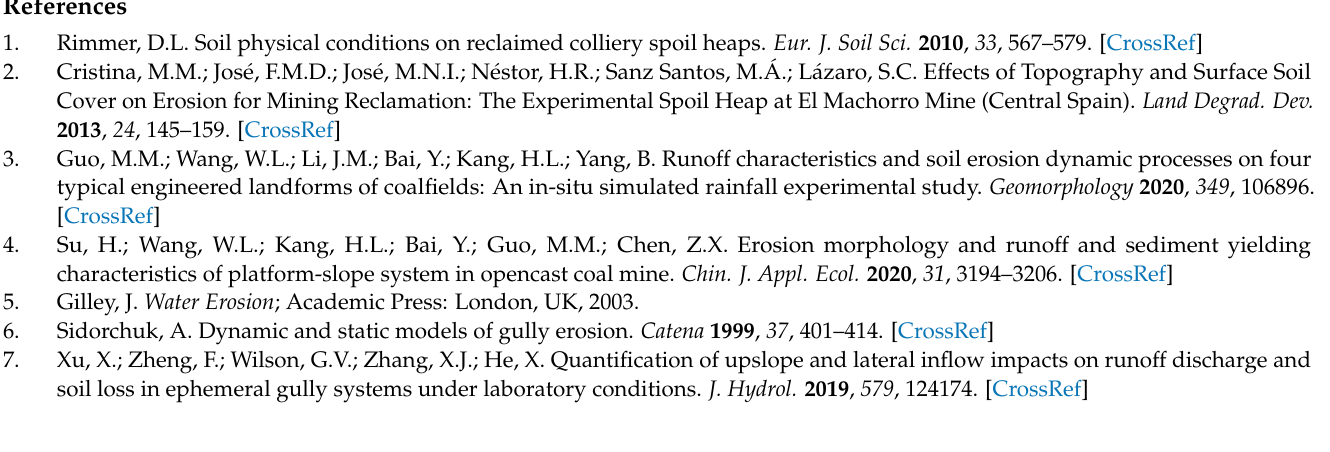
Figure A1. The flow chart of conducting the experiment.